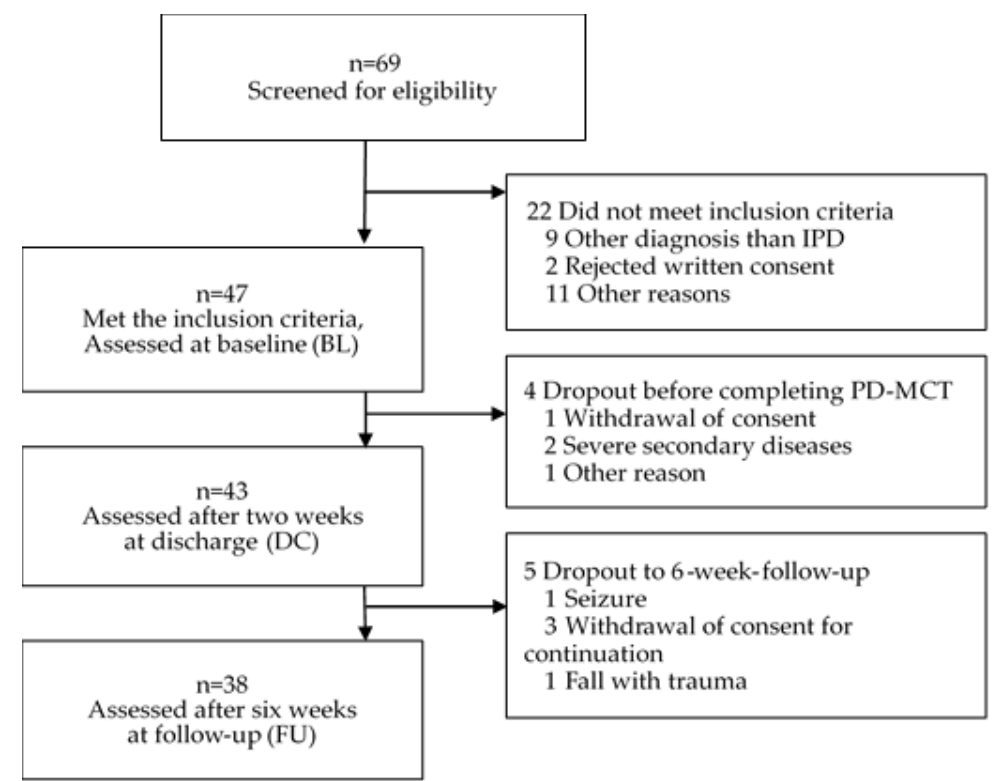
Figure 2. Study Flow Diagram. Data collecting period from November 2017 – September 2018. Table 1. Demographics and clinical characteristics at